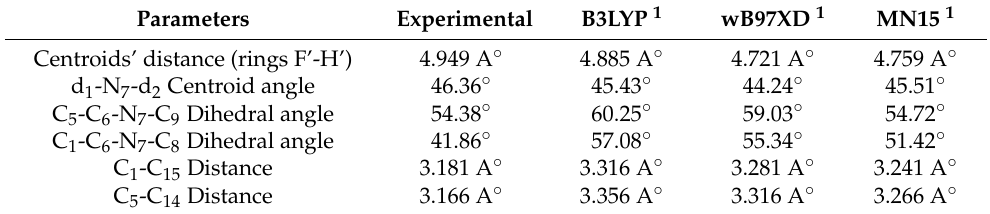
Table 1. The selected experimental and calculated structural parameters of double aza-oxa[7]helicene 3 .